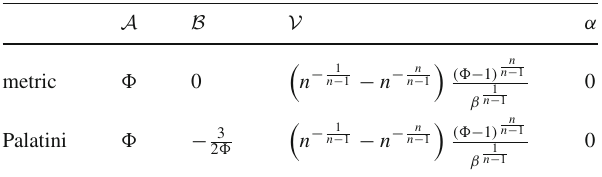
Table 3 Parametrization of the f ( R ) = R + β R n